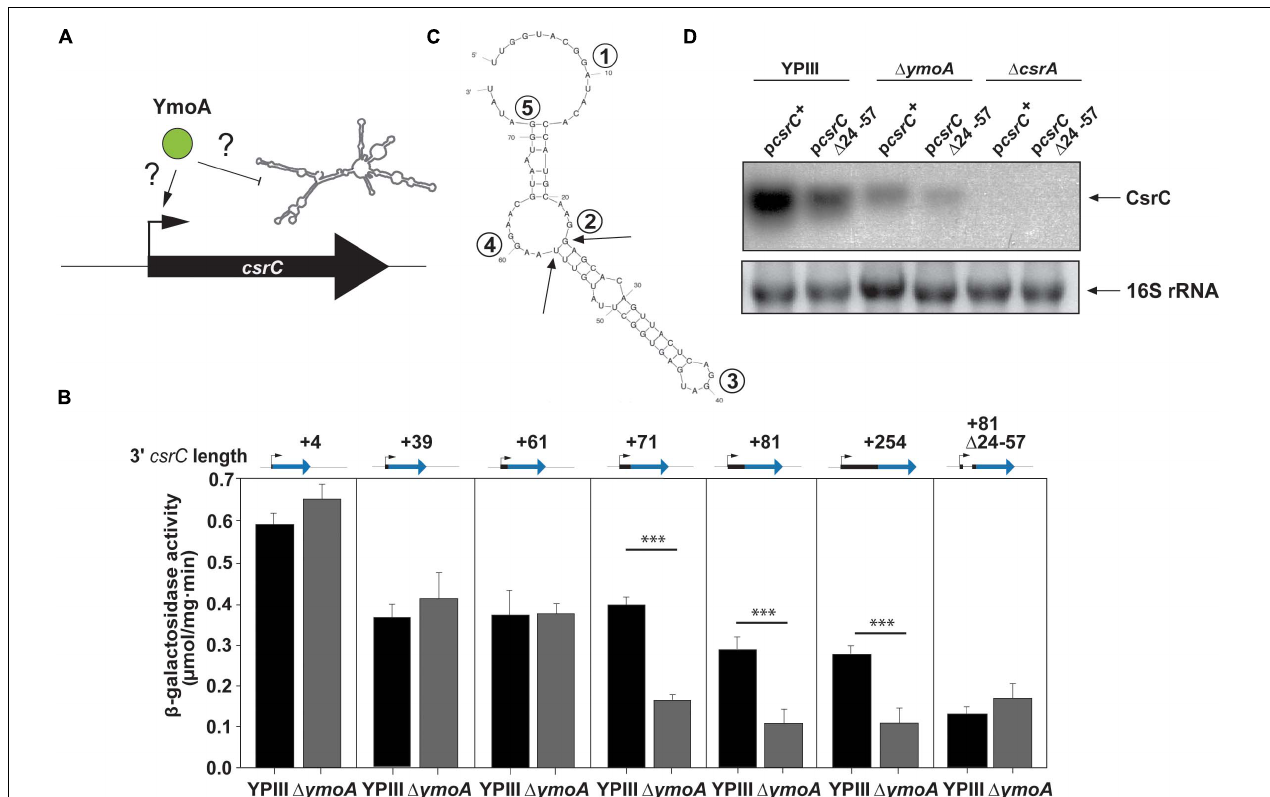
FIGURE 4 | YmoA-mediated control of CsrC occurs on the post-transcriptional level. (A) Model for YmoA influence on CsrC on the transcriptional or post-transcriptional level. Increased CsrC levels can result from increased transcription or decreased degradation of CsrC. (B) Plasmids harboring transcriptional csrC-lacZ fusions with varying 3 (cid:48) -ends of the csrC gene and a csrC (+81)- lacZ fusion with a (cid:49) (+24–+57) deletion (pKB17) were transformed into Y. pseudotuberculosis YPIII and YP50 ( (cid:49) ymoA ). Strains were grown overnight at 25 ◦ C and transcriptional activity of the different fusions was determined by β -galactosidase assays. β -galactosidase activity is given in µ mol min − 1 mg − 1 for comparison. The data represent the average ± SD from at least three different experiments each done in duplicate. The statistical significances between the wild-type and the ymoA mutant were determined by the ANOVA test. P -values: ∗∗∗ : < 0.001. (C) Secondary structure prediction of the CsrC RNA from nucleotide +1 to +76 generated by Mfold. The single-stranded regions including the most highly conserved GGA element of CsrA binding sites are indicated by numbers. The arrows indicate the 5 (cid:48) and 3 (cid:48) end of the (cid:49) (+24–+57) deletion. (D) Y. pseudotuberculosis strains YPIII (wild-type), YP50 ( (cid:49) ymoA ), and YP53 ( (cid:49) csrA ) harboring pKB59 ( csrC + ) or pKB49 ( csrC (cid:49) +24–+57) were grown in LB at 25 ◦ C overnight. Total RNA of the strains was extracted, separated on agarose gels and a CsrC-specific probe was used to detect the CsrC RNA by Northern blotting. The 16S rRNAs are shown as RNA loading